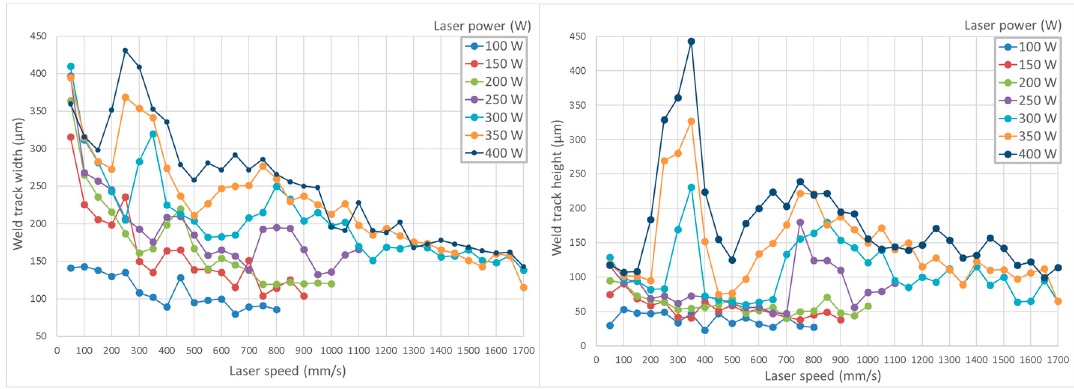
Figure 3. Single track weld evaluation, width and height of the weld according to applied LS and LP. Minimization of the influence of other parameters has certain advantages and disadvantages.